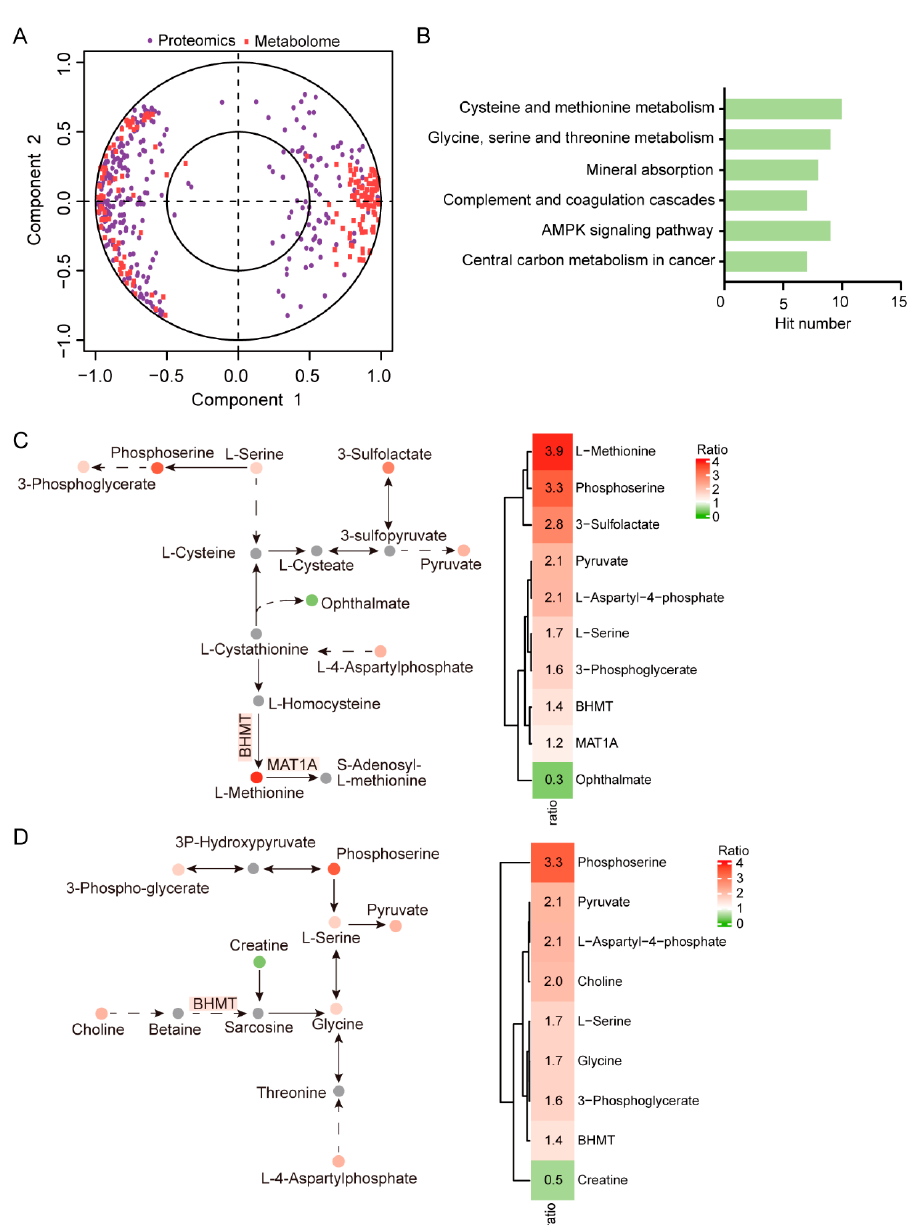
Figure 3. Integrated analysis of metabolome and proteome data. ( A ) Correlation circle plot of differential metabolites and differentially expressed proteins. The included angle (<90 degrees) between a metabolite and protein means positive correlations, and the included angle (>90 degrees) means negative correlations. ( B ) Pathways jointly enriched by differential metabolites and differentially expressed proteins. ( C ) The cysteine and methionine metabolism pathway ( left panel ) and the changes of the involved metabolites ( right panel ). The coded color and corresponding number represent the log2-transformed fold changes in the metabolites. The grey dots indicate non-significant metabolites. ( D ) The glycine, serine, and threonine metabolism pathway ( left panel ) and the changes in involved metabolites ( right panel ). The coded color and corresponding number represent the log2-transformed fold changes in the metabolites. The grey dots indicate non-significant metabolites.